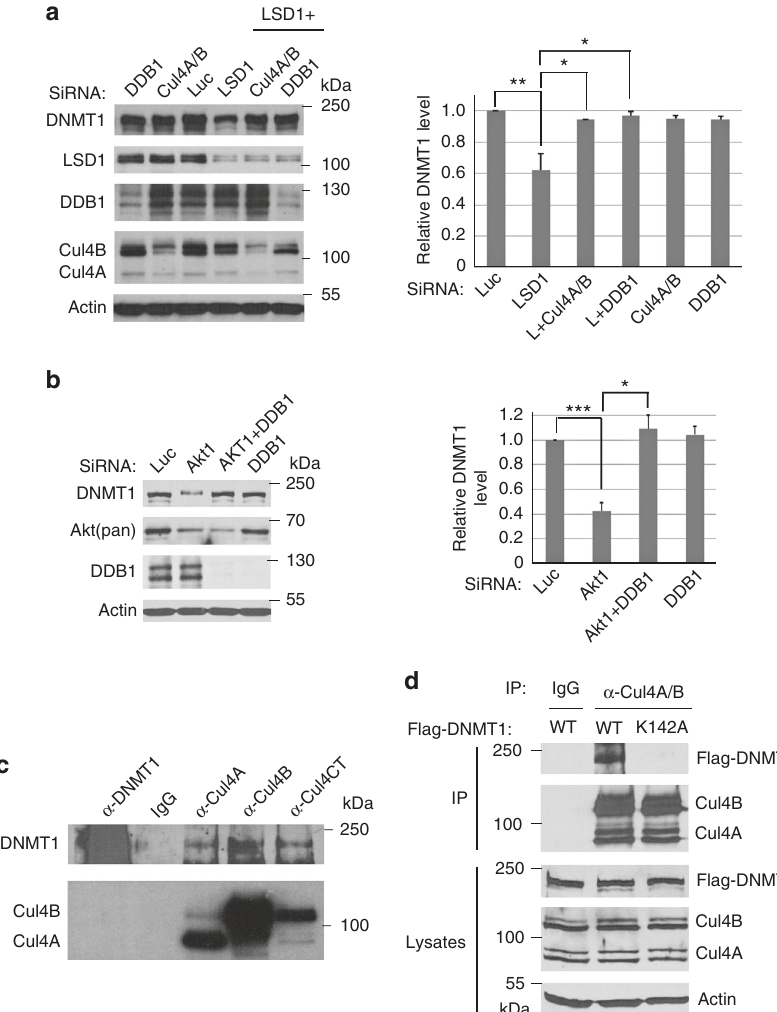
Fig. 2 CRL4 regulates the protein stability of DNMT1. a Loss of CRL4 core components stabilizes DNMT1. HCT116 cells were transfected with 50 nM siRNAs for each of luciferase, CUL4A + CUL4B (CUL4A/B), and DDB1 for 48 h, in the presence or absence of LSD1 siRNA as indicated. The levels of DNMT1 and CRL4 proteins were analyzed by blotting with indicated antibodies on the left. The protein samples were analyzed with three replicate repeats and the proteins bands were quanti fi ed and normalized to the luciferase siRNA control. The quanti fi cations were represented by bar graph with mean and standard deviation (S.D.) for error bars from three replicates. The P value of LDS1 to control (Luc) siRNAs was calculated by independent Student ’ s t-test and the P values of double to single knockdowns were calculated by paired Student ’ s t-test (* P < 0.05, ** P < 0.01). Experiments were repeated three independent times with the same conclusion. b Loss of DDB1 stabilizes DNMT1 in AKT1 knockdown cells. HCT116 cells were transfected with 50 nM siRNAs for Luc or DDB1, in the presence or absence of AKT1 siRNA as indicated for 48 h. The proteins were analyzed and quanti fi ed as in a . Student ’ s t -test was used for signi fi cant differences. * P < 0.05, *** P < 0.001. c The endogenous CRL4 core complexes interact with DNMT1. Endogenous protein complexes were immunoprecipitated (IP) with indicated antibodies and blotted with anti-DNMT1, CUL4A, CUL4B, or CUL4CT (detecting the C termini of CUL4A and CUL4B) antibodies. Non-speci fi c IgG was used as a control. Experiments were repeated four independent times with the same conclusion. d CRL4 binding to DNMT1 is abolished by K142A mutation in DNMT1. HCT116 cells were transiently transfected with the Flag-tagged DNMT1 (WT) or K142A mutant constructs for 48 h. The cells were lysed and proteins were immunoprecipitated by anti-CUL4A/CUL4B antibodies or control IgG. The proteins in the CRL4 complexes were detected by anti-Flag and anti-CUL4A/CUL4B antibodies. Experiments were repeated three independent times with the same